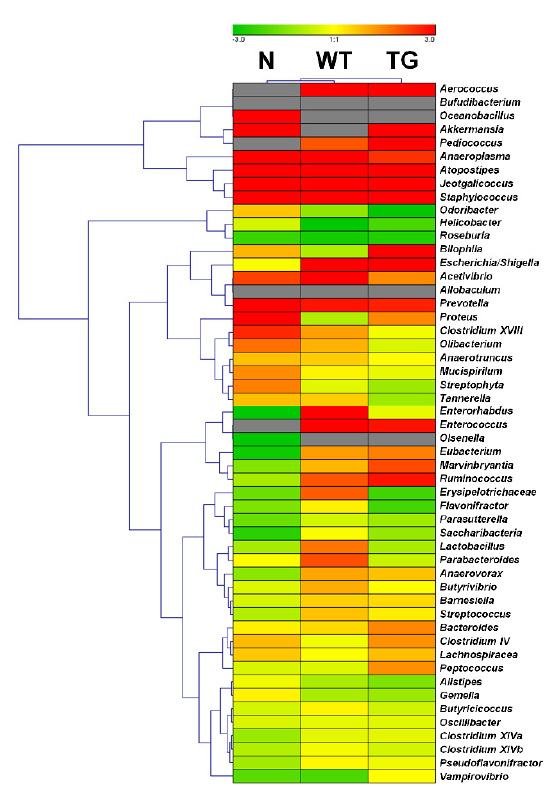
Figure 7. Relative abundance of known bacterial genera in three different conditions. Read numbers for 52 known bacteria genera in the same condition were combined. For each condition, the number of reads at day 7 was compared with the number of reads at day 0. The fold changes were converted into log 2 and imported into the Genesis program. Hierarchical clustering was performed using the complete linkage method. Red and green colors indicate up- and down-regulation, respectively. A gray color indicates that the number of reads associated with the respective bacterium was 0.